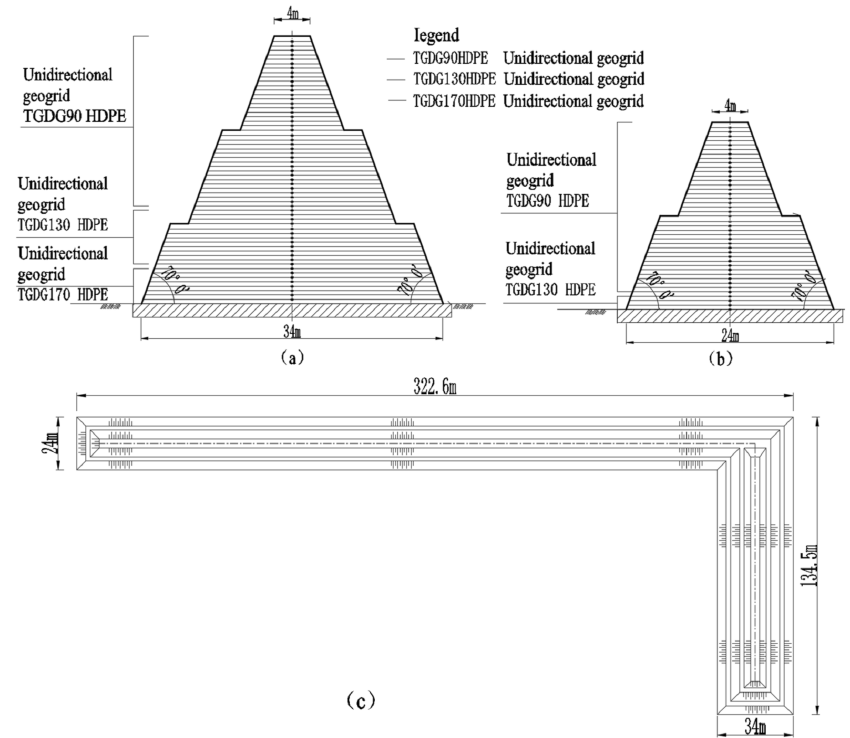
Figure 1. Schematic diagram of soil embankment: ( a ) 30 m soil embankment; ( b ) 20 m soil embank- ment; ( c ) floor plan.